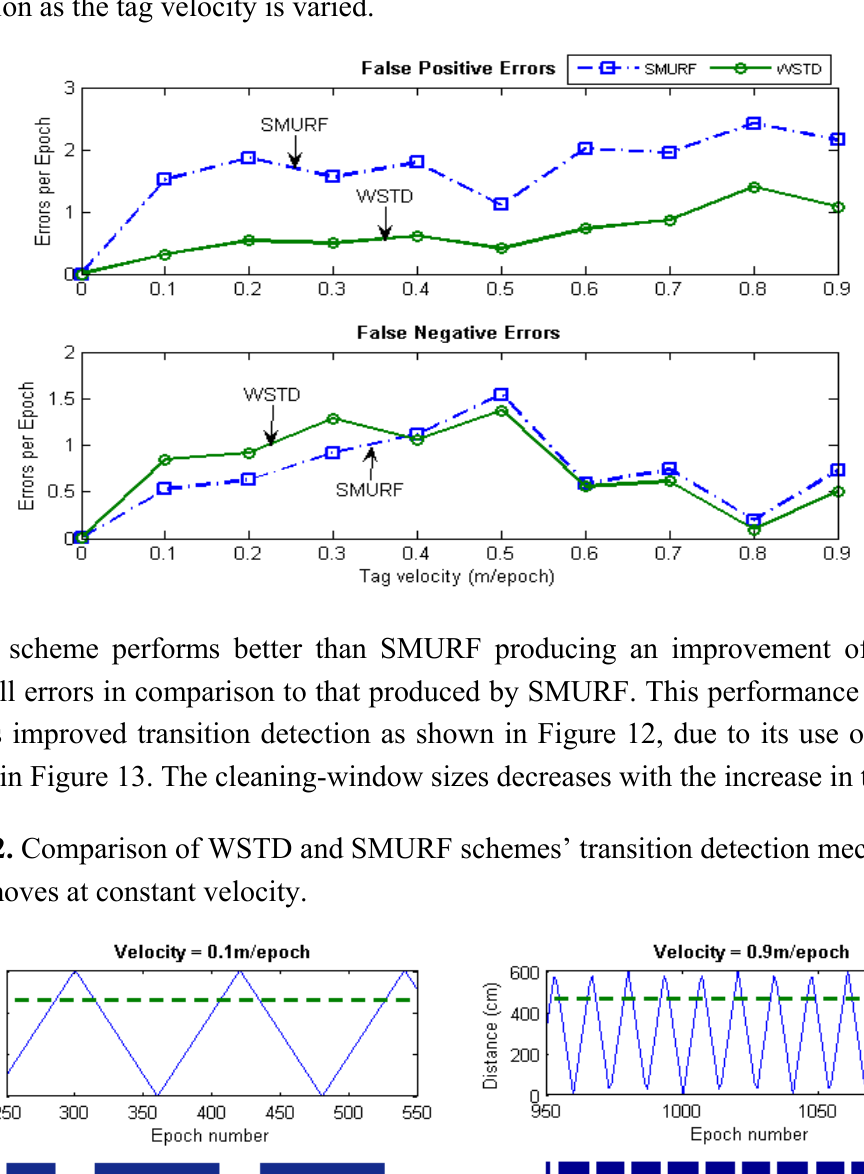
Figure 11. WSTD and SMURF schemes’ false positive and false negative error contribution as the tag velocity is varied.